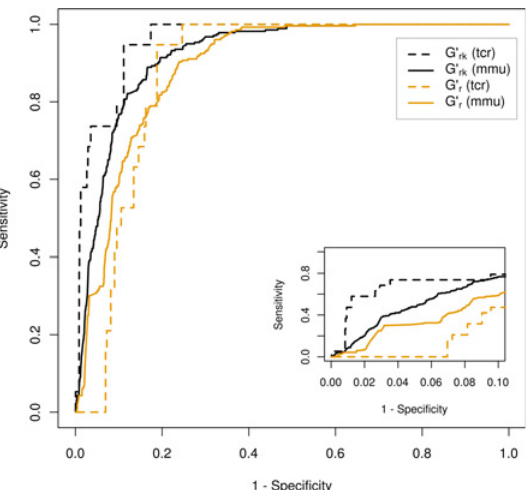
Fig 2. Cross validation procedure of the network-based target prioritization strategy. Receiver Operating Characteristic (ROC) curves for the recovery of Trypanosoma cruzi (TCR, solid black line) and Mus musculus (MMU, dashed yellow line) targets. 19 targets out of 6591 proteins and 280 targets out of 13575 proteins were considered for TCR and MMU respectively.